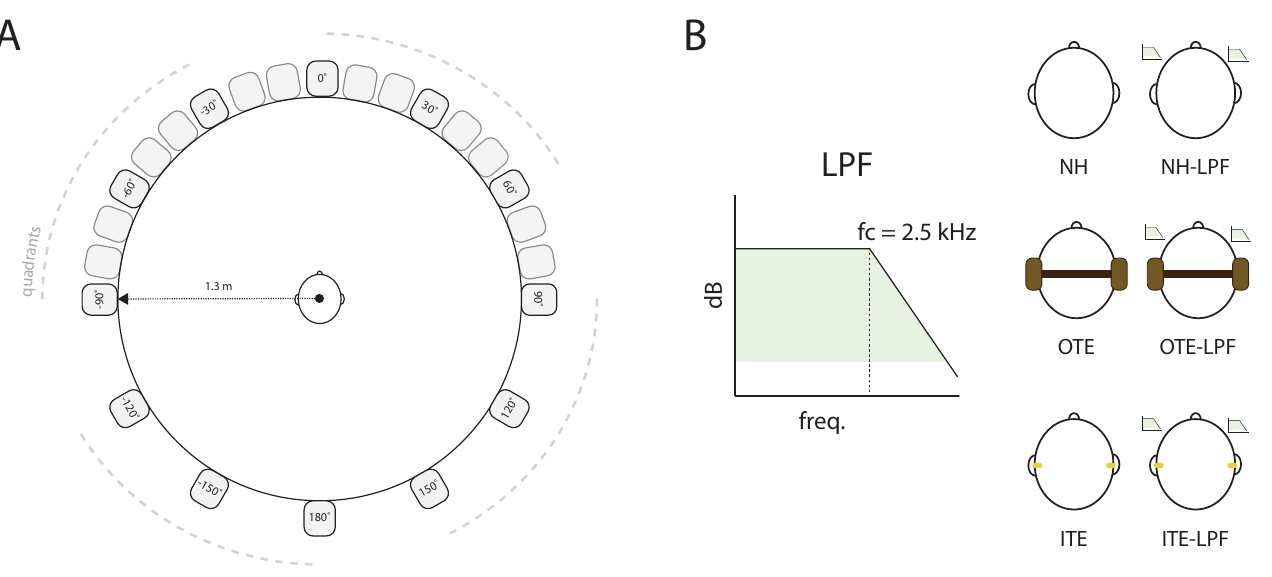
Fig 1. Illustration of the experimental setup and listening conditions. A) Participants were seated in the center of a 24-speaker array. The 12 speakers used to present the stimuli are indicated by their location in azimuth at a speaker-to-speaker distance of 30˚. A single talker was presented from each quadrant for every trial, indicated by the grey dotted lines. B) The 6 listening conditions (normal hearing, with low-pass filtering, and with over-the-ear (OTE) or in-the-ear (ITE) HPDs, see section E) and the low-pass filtering applied to simulate NIHL are visualized.